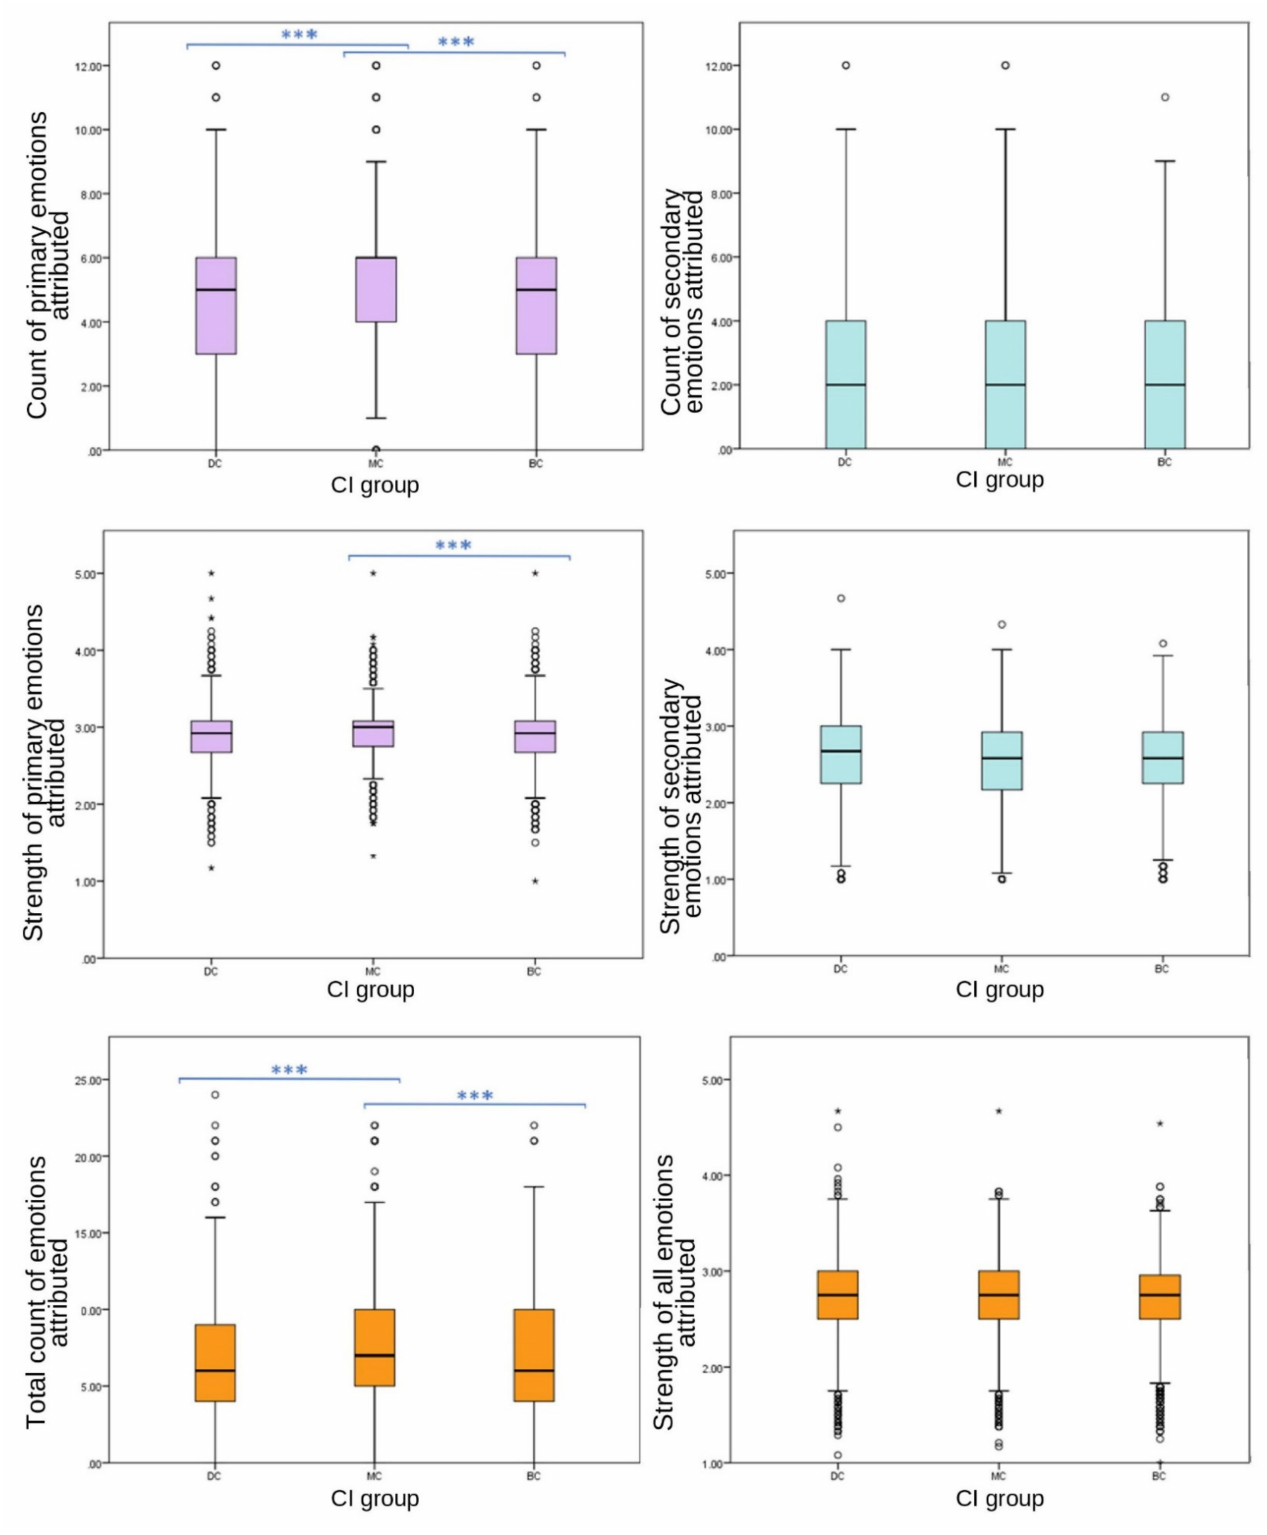
Figure 4. Box plots describing mean scores of grouped primary, secondary and total emotion attribution strength and frequencies between CI groups of dog images. All variables were calculated using four emotions, apart from the total count and strength emotions, which included eight emotions. Strength was measured using a 5-point Likert scale. (*** demotes statistically significant differences. ◦ denotes